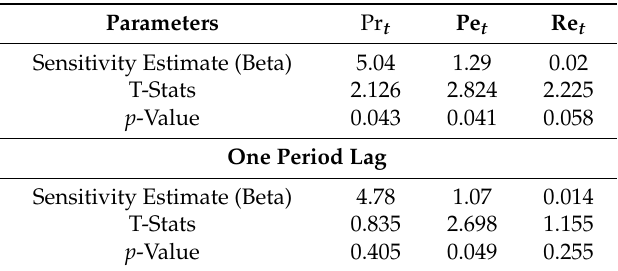
Table 3. Bank Performance Measures and Time Dimensions.